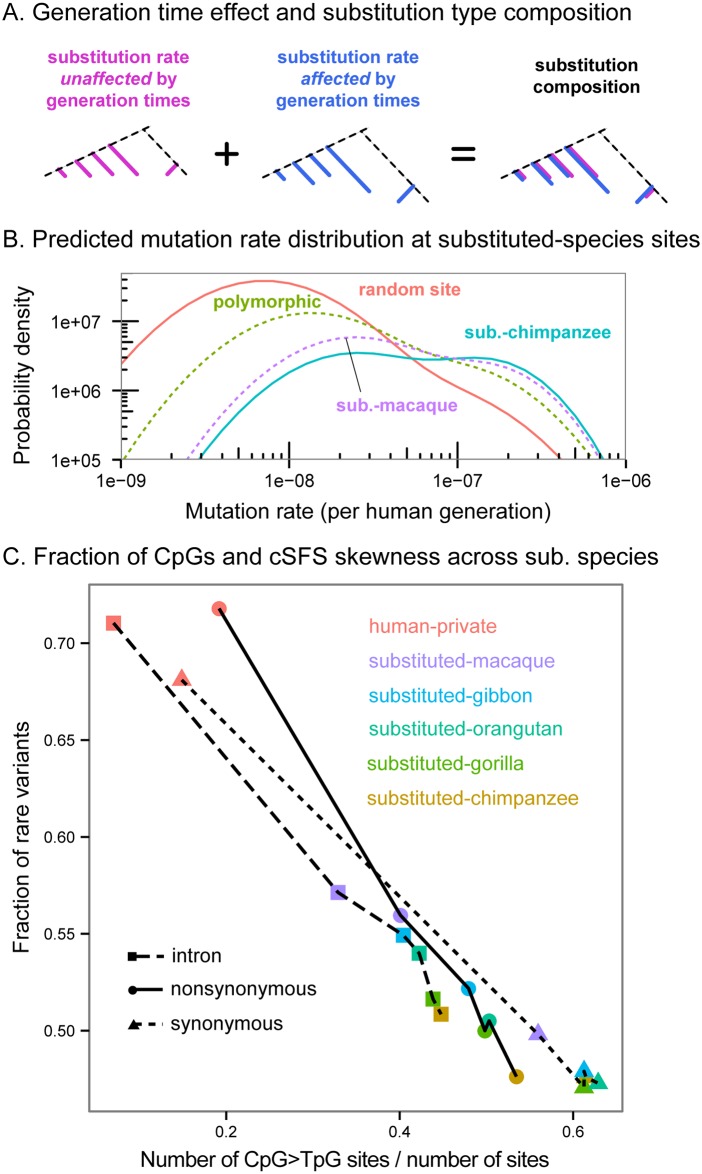
(A) Some mutation types accumulate in a roughly constant yearly rate across different primate lineages. For these mutation types the expected number of substitutions on an evolutionary branch is proportional to the branch length in years (pink). The yearly rates of other substitution types (blue) depends on various life-history traits like generation times (“generation time effect”). As a result, the composition of substitution types in a lineage depends on lineage-specific traits like generation times; this is illustrated by the blue to pink ratio, which differs across lineages. (B) Model-based expectations for the distribution of mutation rates at substituted-species sites. These results were computed using a theoretical model and a set of realistic parameters. At substituted species sites, we expect a distribution skewed towards higher mutation rates compared to random sites, or to random polymorphic sites. In addition, the distribution of mutation rates is skewed towards higher mutation rates for substituted-species with longer generation times; for the primates we considered in this work, this would imply higher mutation rates for more closely-related substituted-species. (C) CpG transitions enrichment is a strong predictor of cSFS skewness in real data.